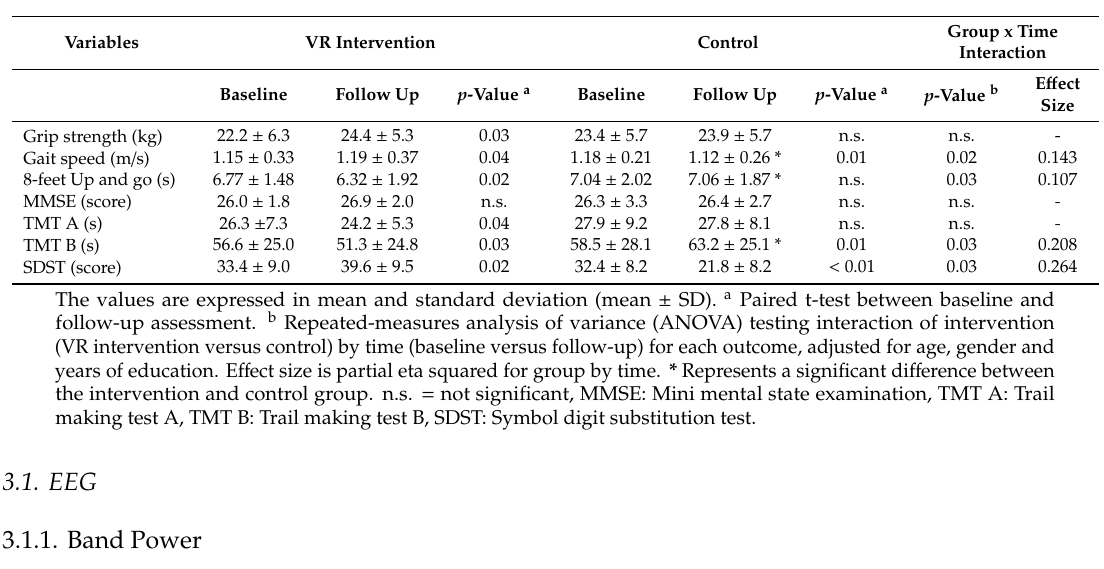
Table 2. The comparison of physical function and global cognitive function between baseline and post intervention in the VR intervention and the control